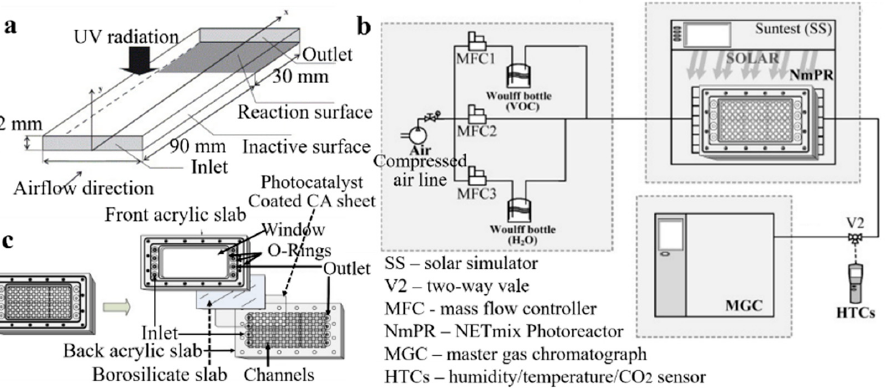
Figure 6. The geometric dimension of the plate-type reactor ( a ) [100]. Copyright 2007, Elsevier. Schematic representation of the microreactor facility: air stream generation unit; solar simulator with photoreactor; master gas chromatography analytic system ( b ) and Schematic representation of the photoreactor ( c ) [102]. Copyright 2017, Elsevier.